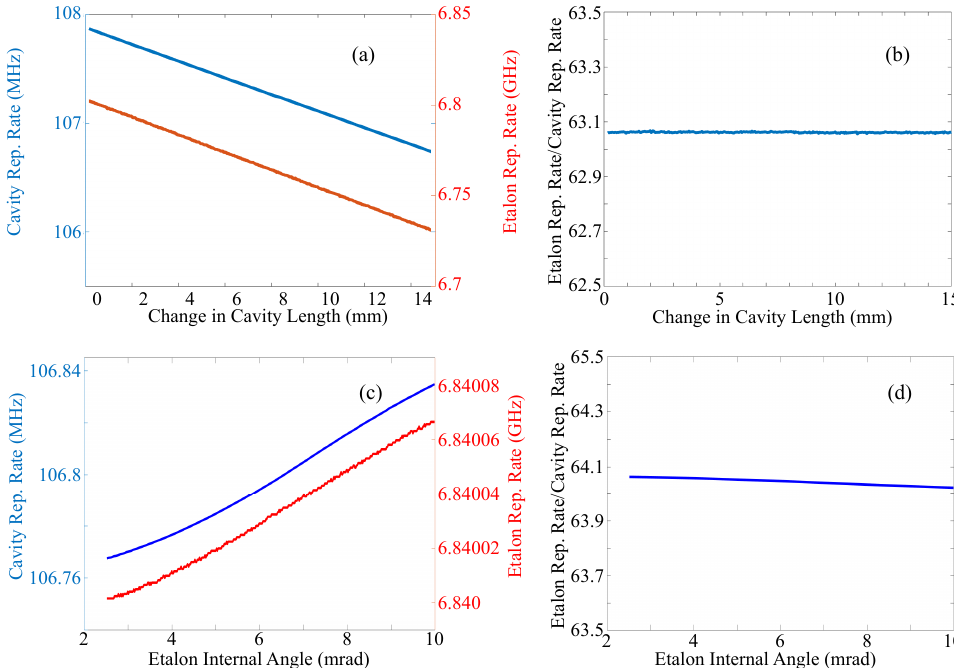
Figure 8. ( a ) Plot of the repetition rate of a single pulse within the nested etalon (blue line) and that of the pulse bunch in the larger cavity, as function of the laser cavity length. ( b ) Ratio of the two frequencies. ( c ) Plot of the two repetition rates of the parent cavity and the etalon taken simultaneously while the angle of the nested etalon is scanned. ( d ) Ratio of these two frequencies.